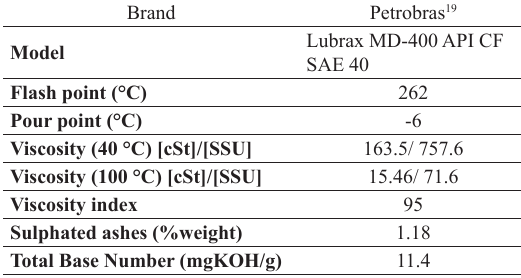
Table 2. Physical-chemical properties of the lubricant API CF SAE 40.